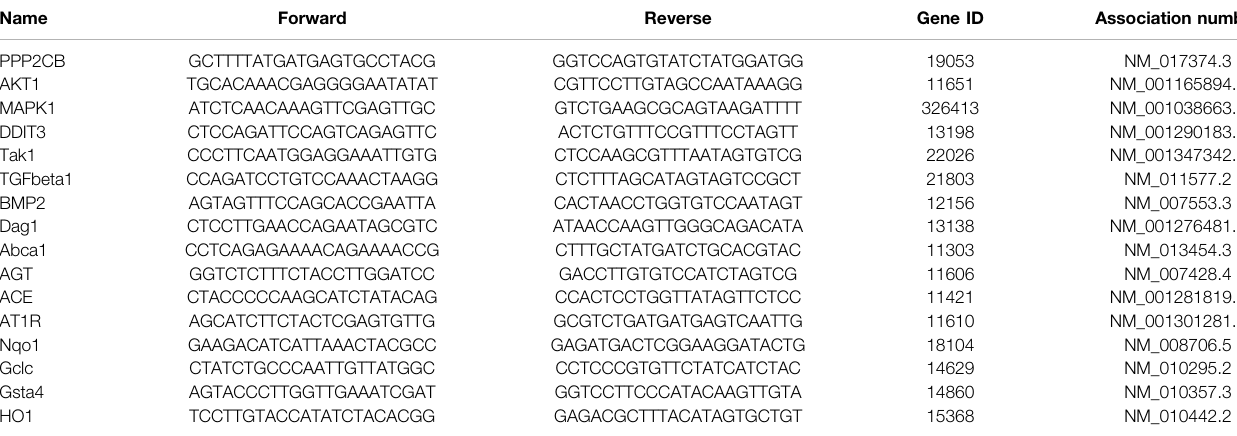
TABLE 1 | Primer sequences used in qRT-PCR.